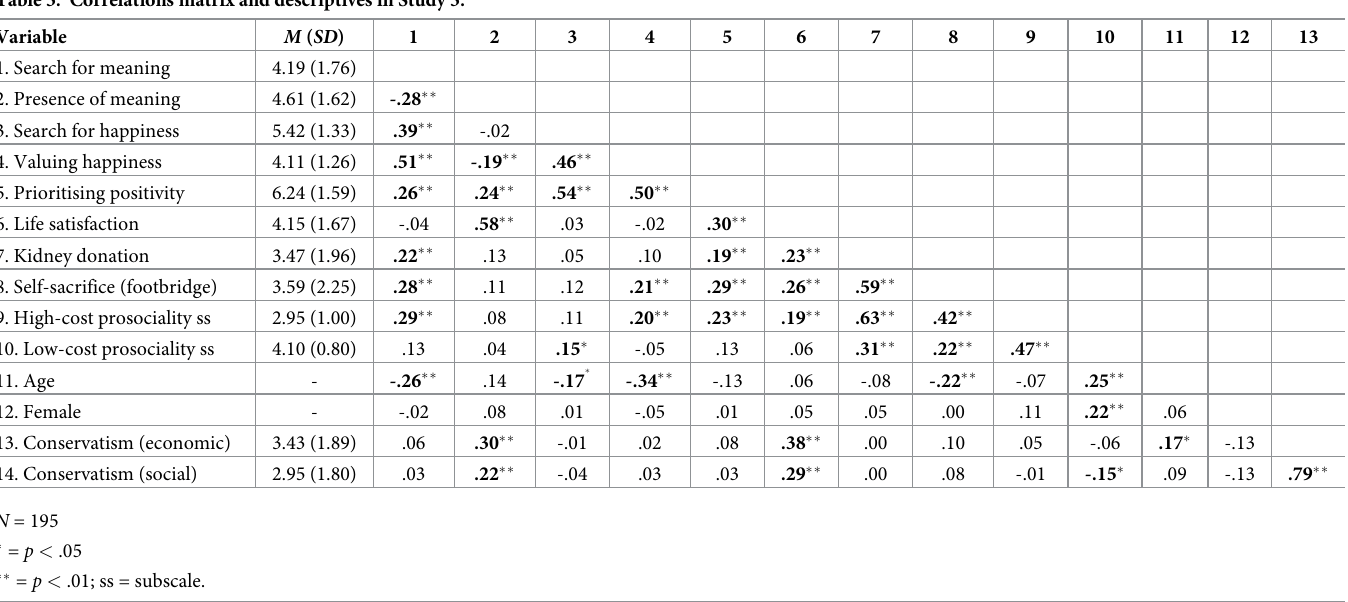
As in Study 2, we further tested our hypothesis using multiple regressions predicting each prosociality variable with search for meaning, while including presence of meaning, happi- ness-pursuit, life satisfaction, and demographic variables as co-variates (Table 6). These regres-